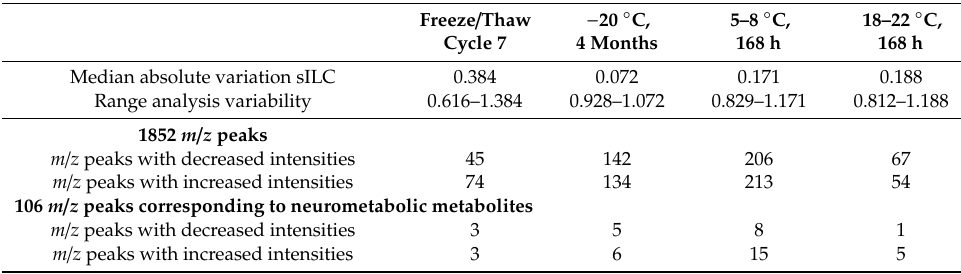
Table 3. Number of metabolites possibly a ff ected by the most extreme storage condition, after correction for the analysis